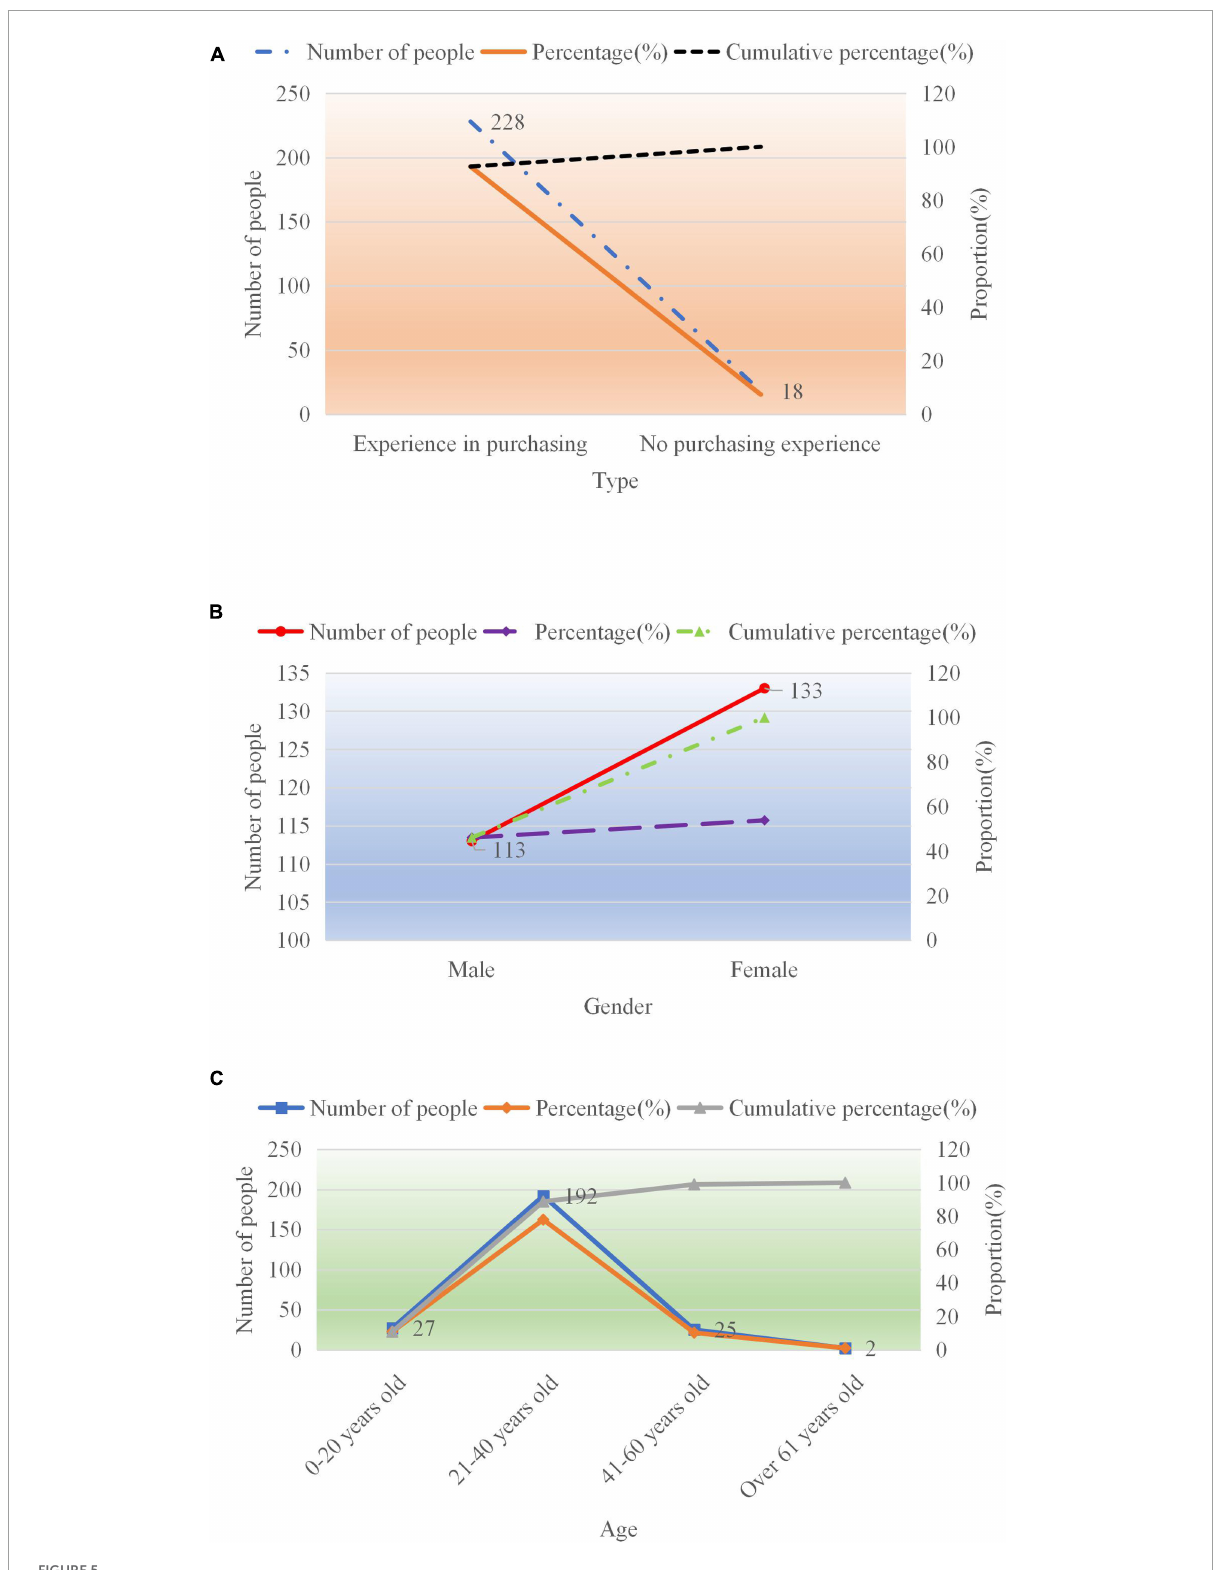
FIGURE5 Basic information of the respondents. Panel (A) indicates whether the respondents have purchased the goods of the store, panel (B) indicates the gender of the customers, and panel (C) indicates the age of the